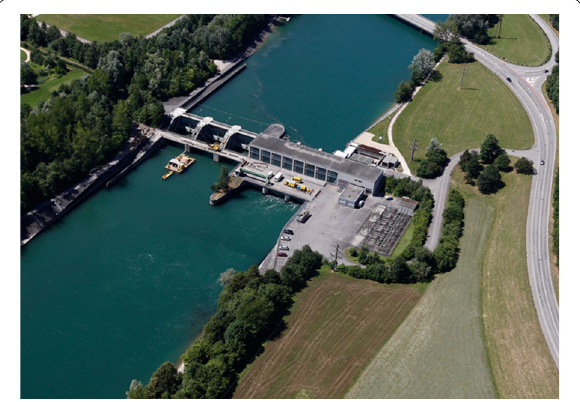
Fig. 6 River hydropower station running on the River Tiber (Source: Ministry of the